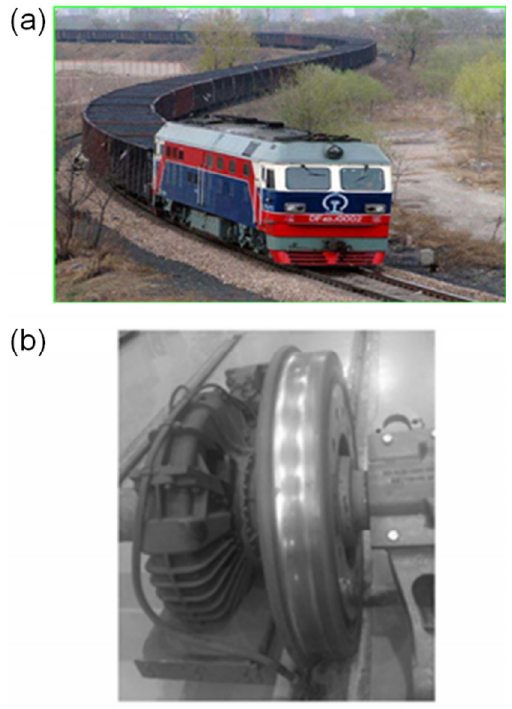
Fig. 13 Photographs of (a) a heavy-duty train and (b) an out-of- round high-speed train wheel. Reproduced with permission from Ref. [88]. © SAGE Publications, 2016.